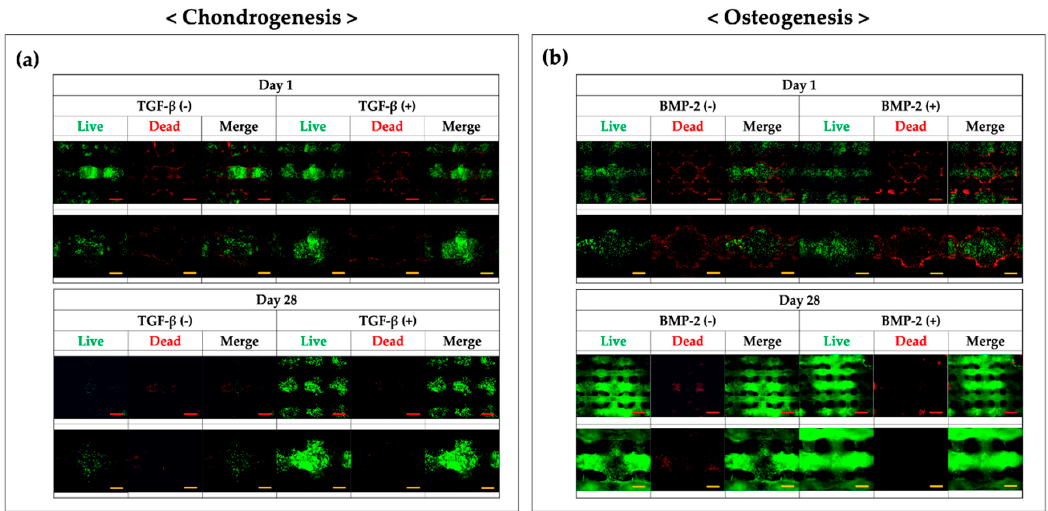
Figure 7. Viability of cells on the hybrid scaffold, as determined using the Live/dead assay. The green and red dots represent live and dead cells, respectively. ( a ) Hybrid scaffolds in chondrogenic induced medium. ( b ) Hybrid scaffolds in osteogenic induced medium. Red bar scale: 1000 μ m; yellow bar scale: 500 μ m.